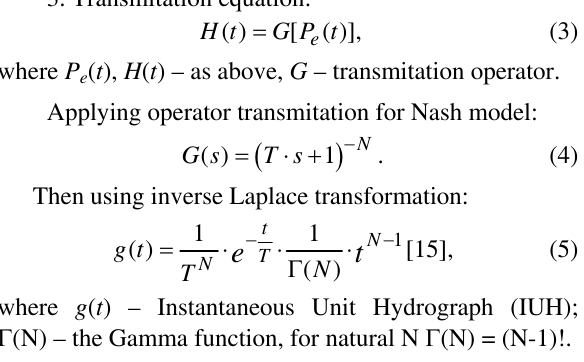
Fig 1 . Block diagram of the rainfall-runoff model